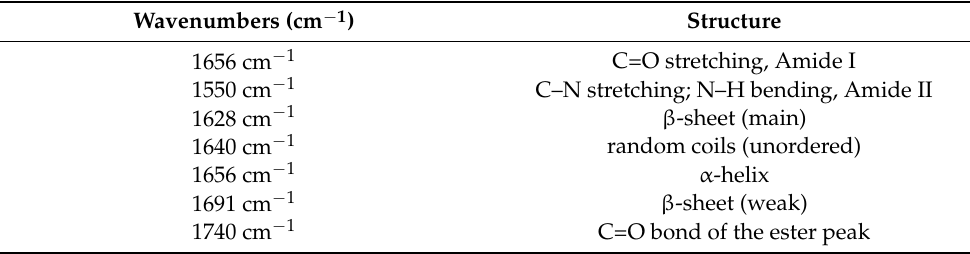
Table 1. Summary of peak positions used in the study.